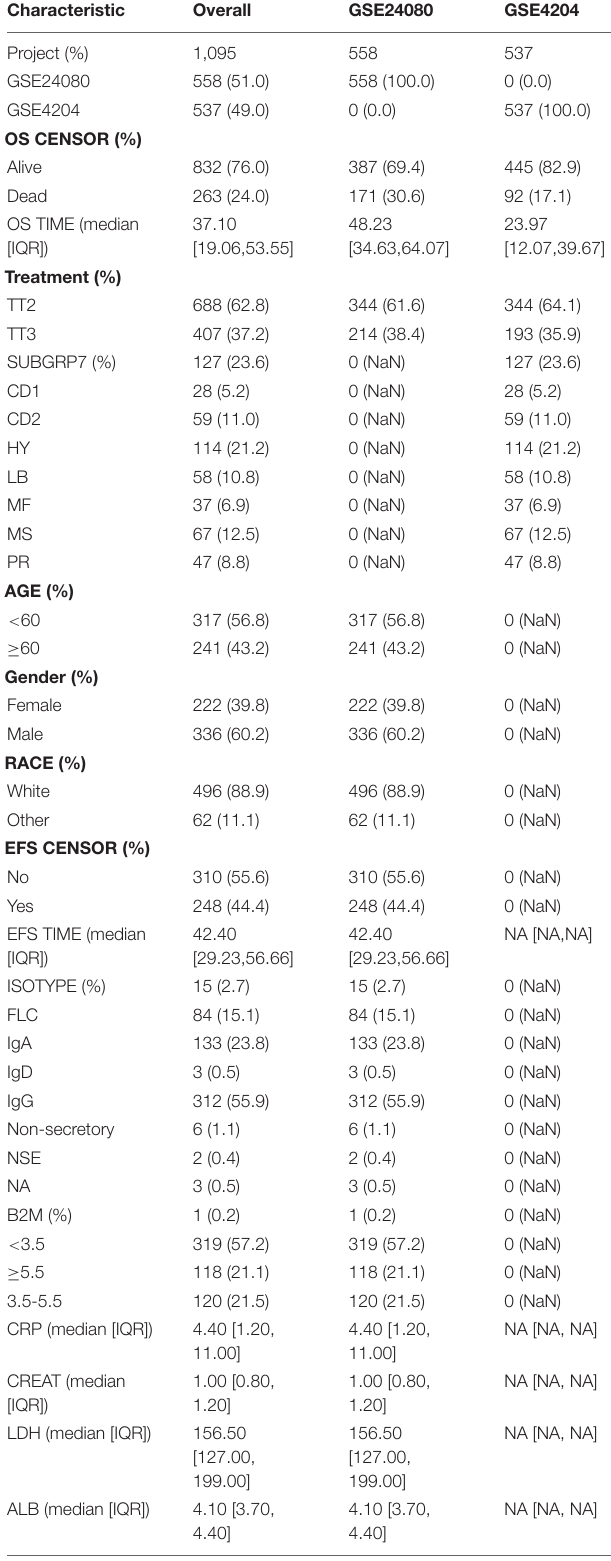
TABLE 1 | Baseline characteristics of multiple myeloma (MM)